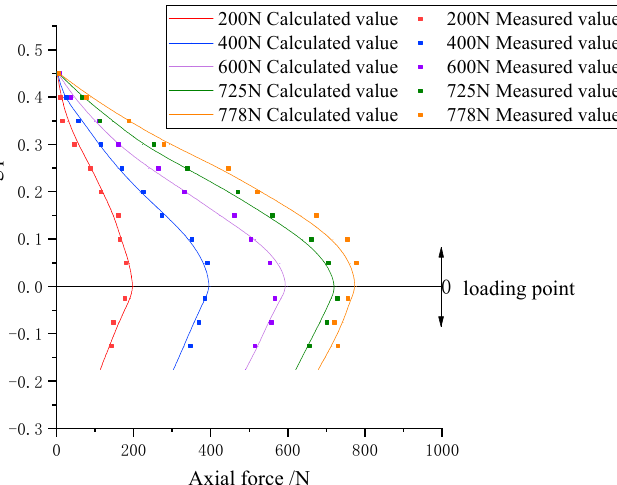
Figure 10. Distribution of axial force across the measure pile body at various loading levels.